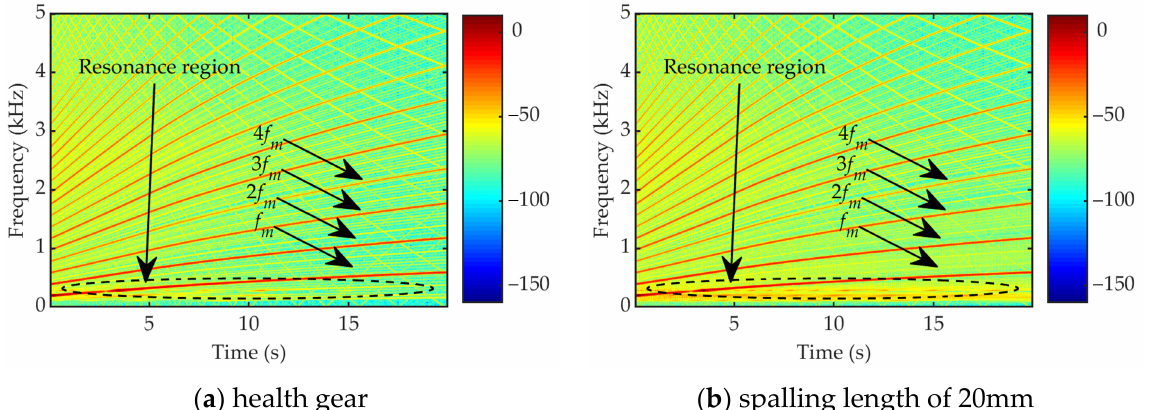
Figure 12. Comparison of time–frequency spectrum of healthy and maximum spalling length gears without track irregularities.